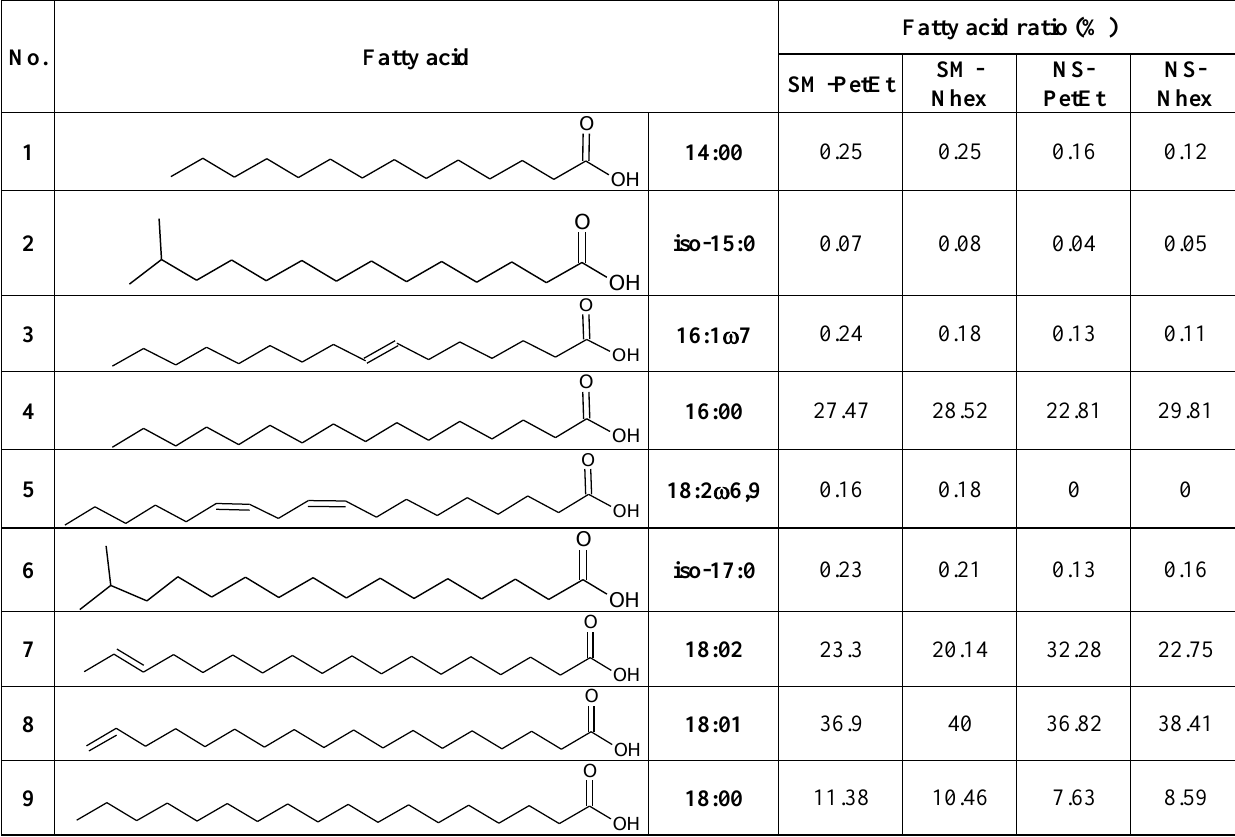
Figure 2: GC-MS/MS spectroscopy analysis of the organic extracts a: Silybum marianum seeds using petroleum ether and n -hexane, b: Silybum marianum seeds using n -hexane, c: Nigella sativa seeds extract using petroleum ether and n -hexane, d: Nigella sativa seeds extract using n -hexane. The peaks 1= 14:00, 2= iso-15:0, 3= 16:1  7, 4= 16:00, 5= 18:2  6,9, 6= iso-17:0, 7= 18:02, 8= 18:01, and 9= 18:00 fatty acids). Table 2: Percentage of the fatty acid content of both Silybum marianum & Nigella sativa plant seed extracts using petroleum ether and n